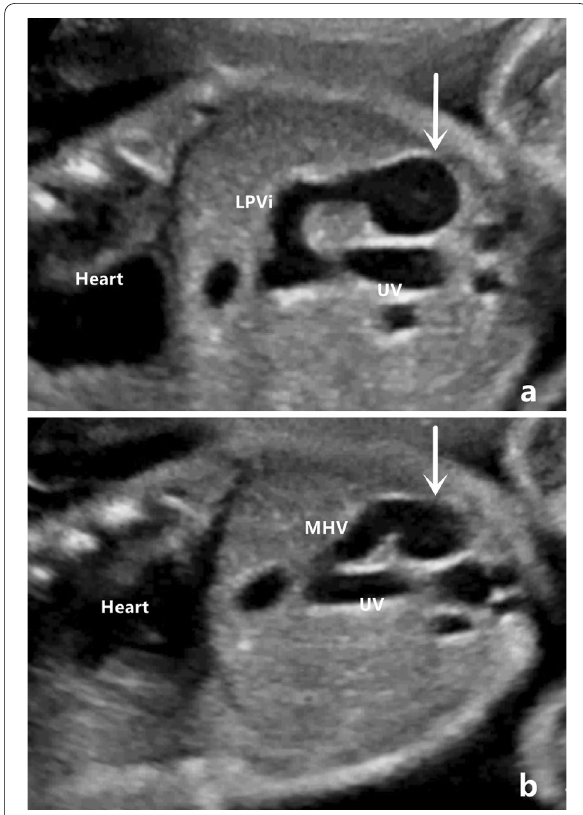
Fig. 1 Cystic expansion at the shunt. This figure shows a shunt between the inferior left portal vein (LPVi) and middle hepatic vein (MHV). The arrow points to cystic expansion at the shunt. UV: umbilical